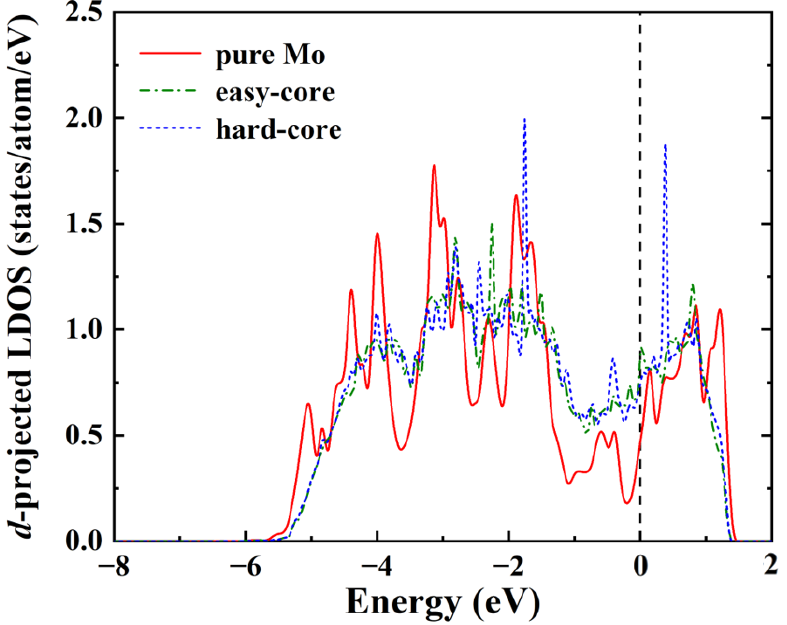
Figure 4. Local d -DOS of Mo in the bulk and in the dislocation core with easy-core and hard-core configuration. core